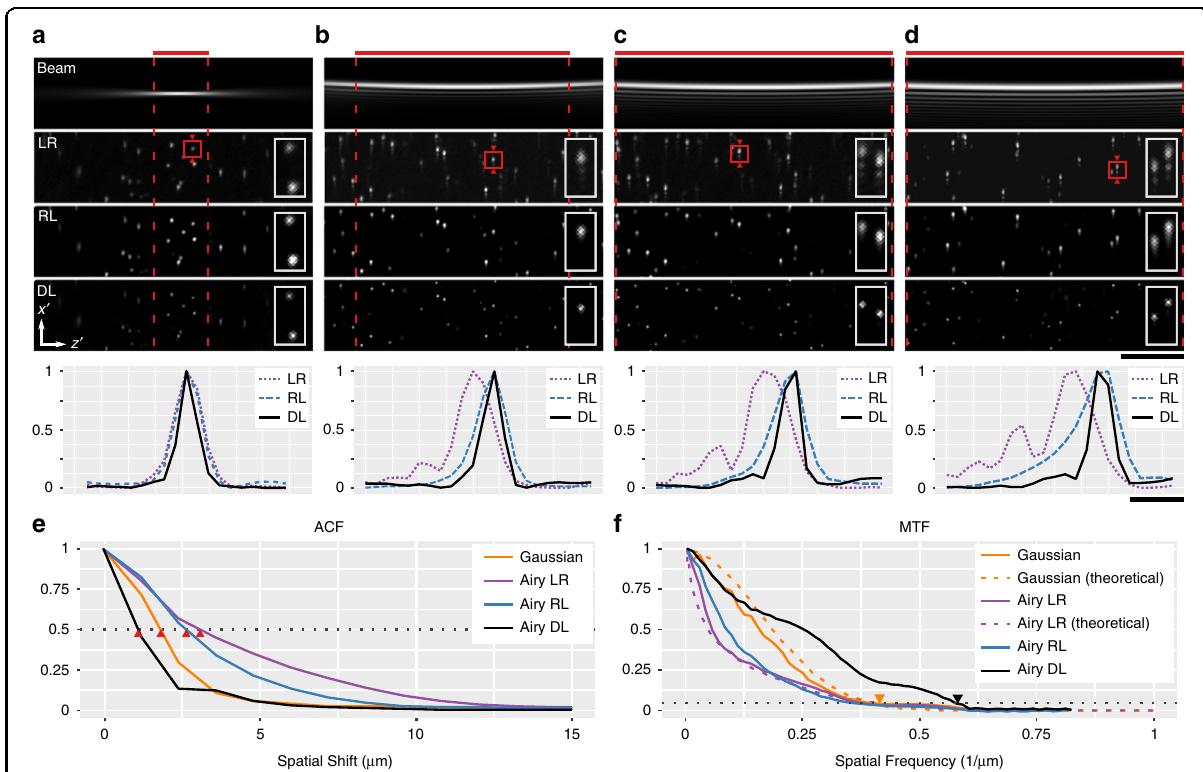
Fig. 3 Experimental veri fi cation of learned deconvolution in beads. a – d show the illumination beam and the corresponding acquired LSM image (LR), which is deconvolved using Richardson – Lucy (RL) and deep-learning (DL) methods. a Gaussian, b Airy ( α = 0.5), c Airy ( α = 1) and d Airy ( α = 2) beam. Insets and pro fi les correspond to the bead marked by a red square. Red dashed lines mark the Rayleigh range of each beam. Scale bars are 50 μ m for images and 5 μ m for plots. e Autocorrelation function (ACF) and f modulation transfer function (MTF) with respect to depth of the Gaussian and Airy ( α = 1) LSM